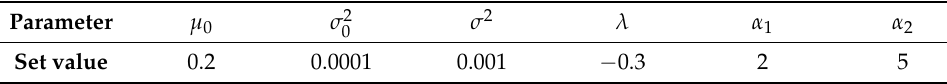
Table 3. Initial value settings of degradation model parameters.